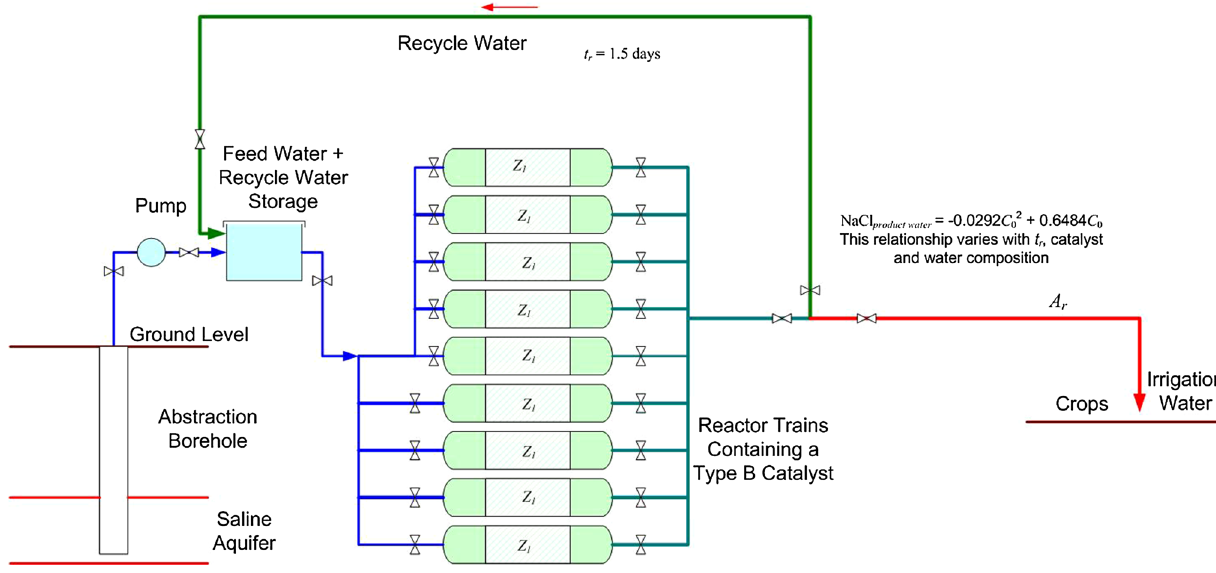
Fig. 13 Process flow diagram for the partial desalination of irrigation water using a Type B